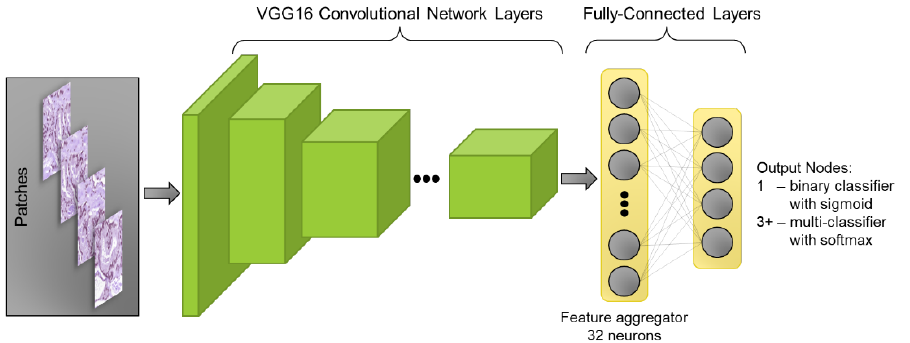
Figure 7. CNN feature layers, with dense classification layer.